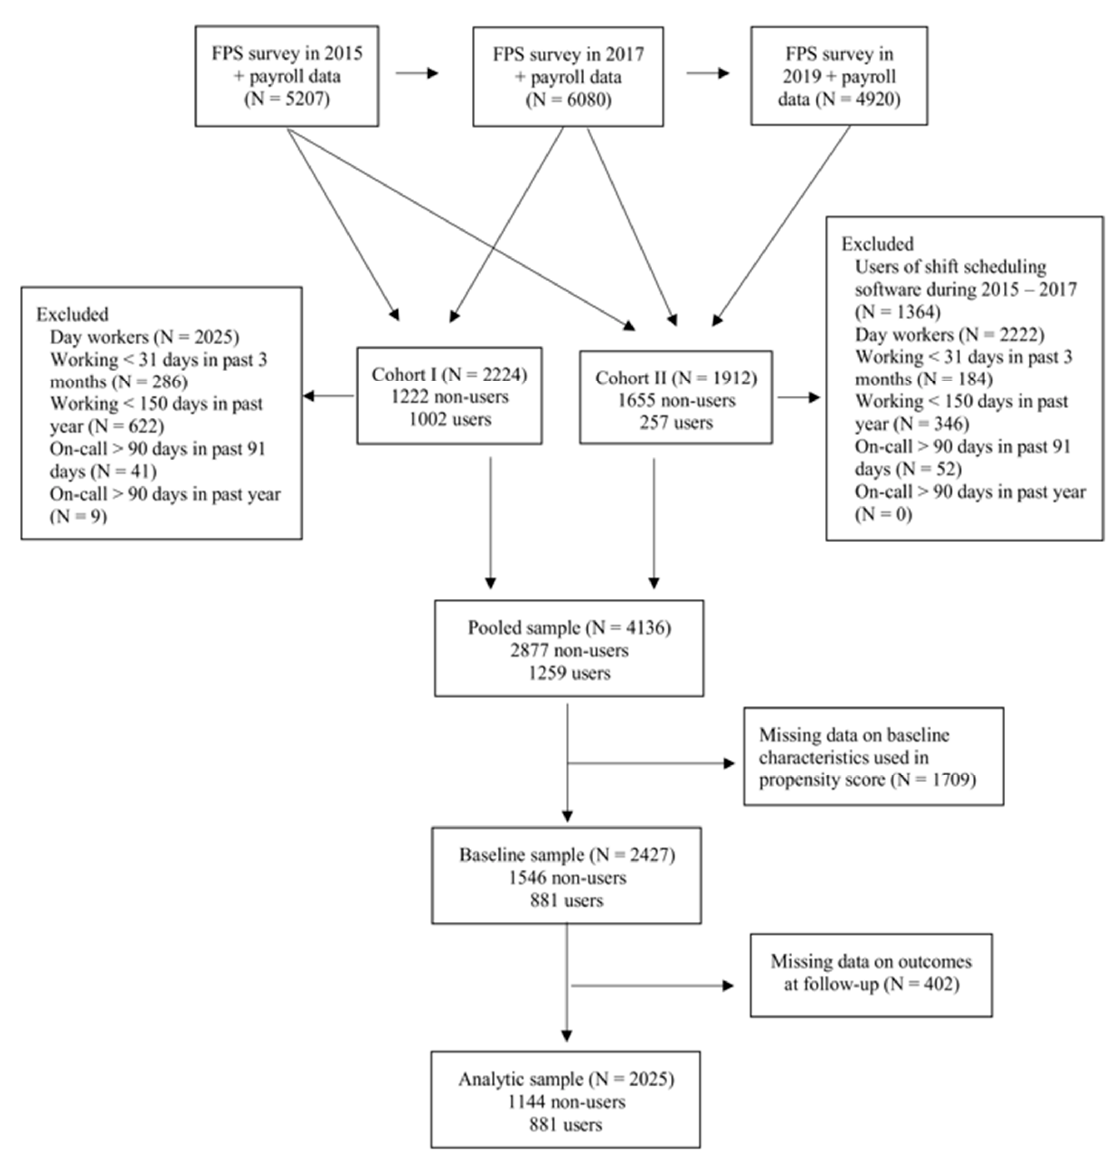
Figure 1. Flow chart of the study population, the Working Hours in the Finnish Public Sector (FPS) study.